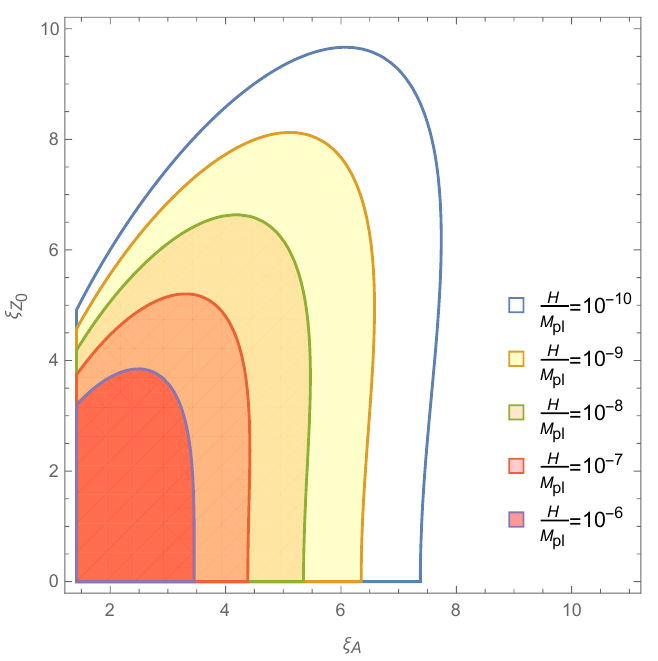
Figure 11 . The parameter space ( (cid:24) A ; (cid:24) Z less than 10 (cid:0) 2